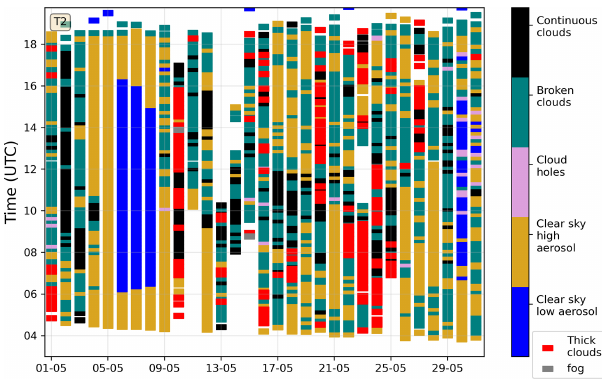
Figure C1. Daily variability of the sky conditions for May 2018 retrieved using MAX-DOAS measurements along the azimuth di- rection of T2. Consistent sky conditions were retrieved for the other three azimuth